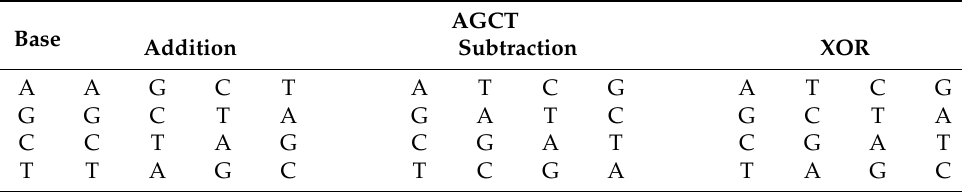
Table 2. DNA Base Addition, Subtraction, and XOR